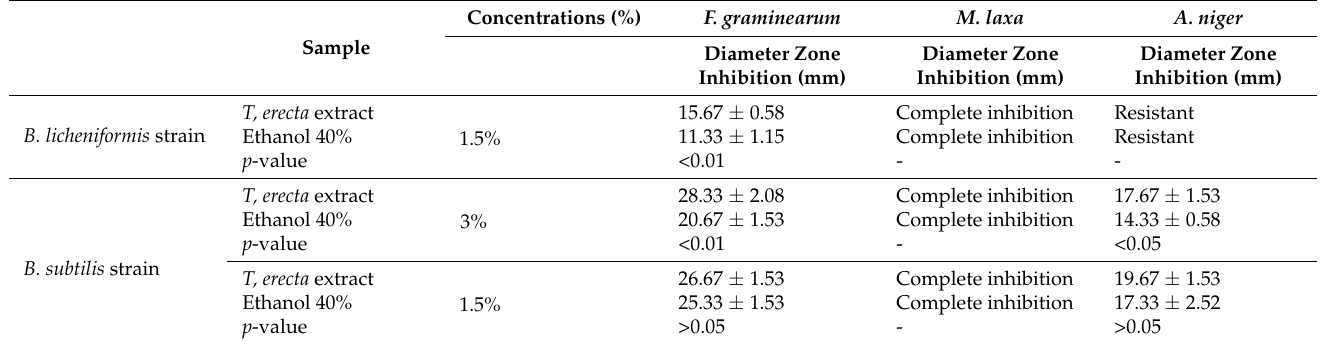
Table 7. The diameters of the inhibition zone to phytopathogens’ mycelial growth given by Bacillus licheniformis or Bacillus subtilis in the presence of different T. erecta extract concentrations. Concentrations (%) F. Sample